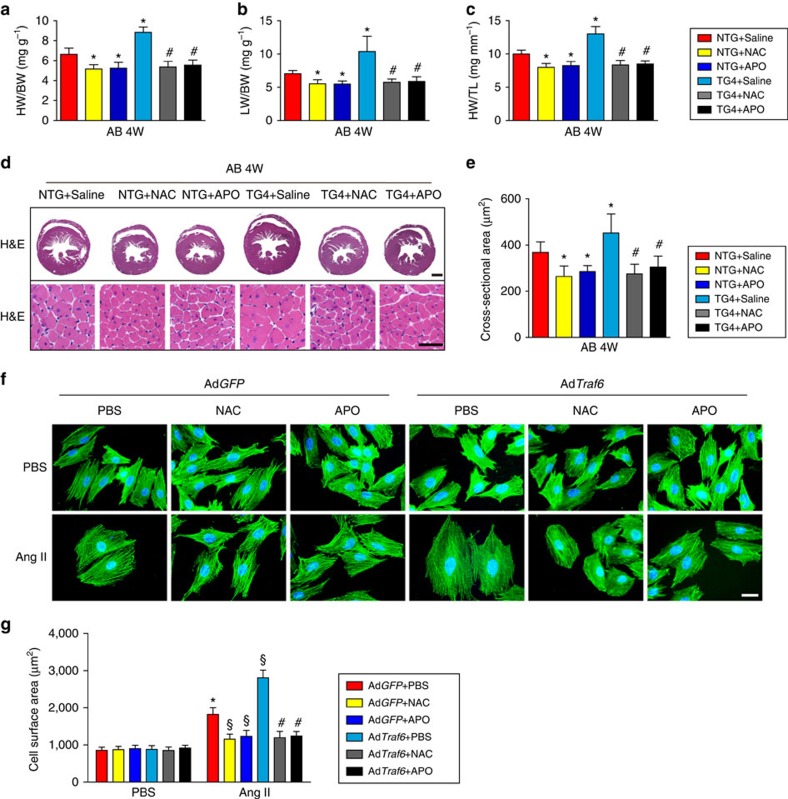
Blocking ROS reverses Traf6-regulated exacerbation of cardiac remodeling.(a–c) The HW/BW (a) LW/BW (b) and HW/TL (c) ratios in the Traf6-TG4 mice and their NTG controls treated with saline, NAC or APO after AB surgery for 4 weeks (n=11–13 per group in a–c). (d,e) Representative images of HE staining (n=6–8 mice per group; scale bar, 1,000 μm for the upper most set of panels and scale bar, 50 μm for lower panels, (d)) and the cross-sectional areas (n>100 cells per group, (e)) of heart sections from mice in the indicated groups. In a–e *P<0.05 versus NTG saline group; #P<0.05 compared to TG4 saline group. (f,g) Representative images (scale bar, 20 μm, (f)) and calculated cell surface areas (n>50 cells per group, (g)) of α-actinin-stained NRCMs that were infected with AdGFP or AdTraf6 and treated with PBS or Ang II in the presence or absence of NAC or APO. *P<0.05 versus AdGFP/PBS+PBS group; §P<0.05 versus AdGFP/Ang II+PBS group; #P<0.05 versus AdTraf6/Ang II+PBS group. Data are presented as the mean±s.d. Statistical analysis was carried out by one-way ANOVA.